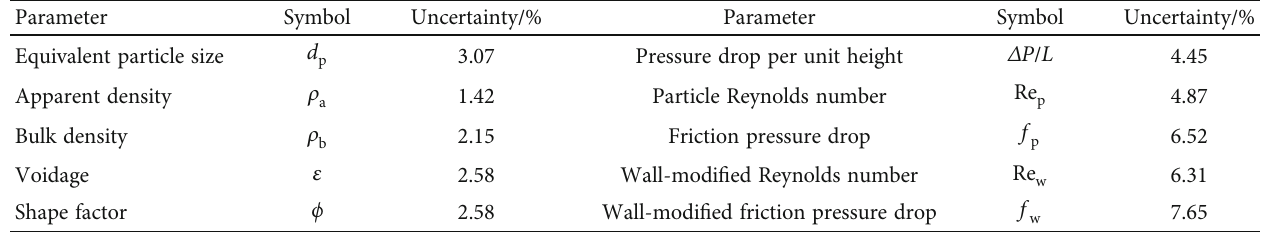
Table 3: Summary of the relative uncertainty of main